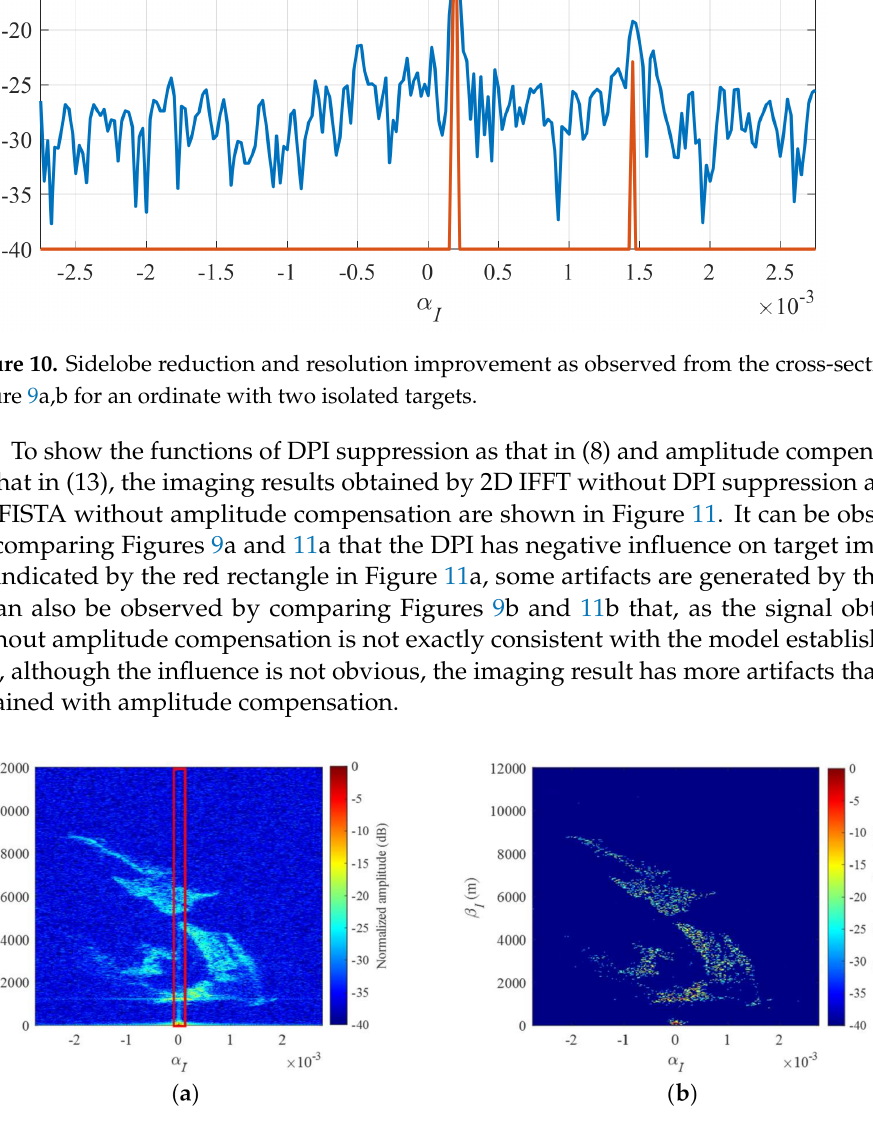
Figure 11. Imaging results of the mountainous area in Besançon obtained by ( a ) 2D IFFT without DPI suppression as that in (8) and ( b ) 2D FISTA without amplitude compensation as that in